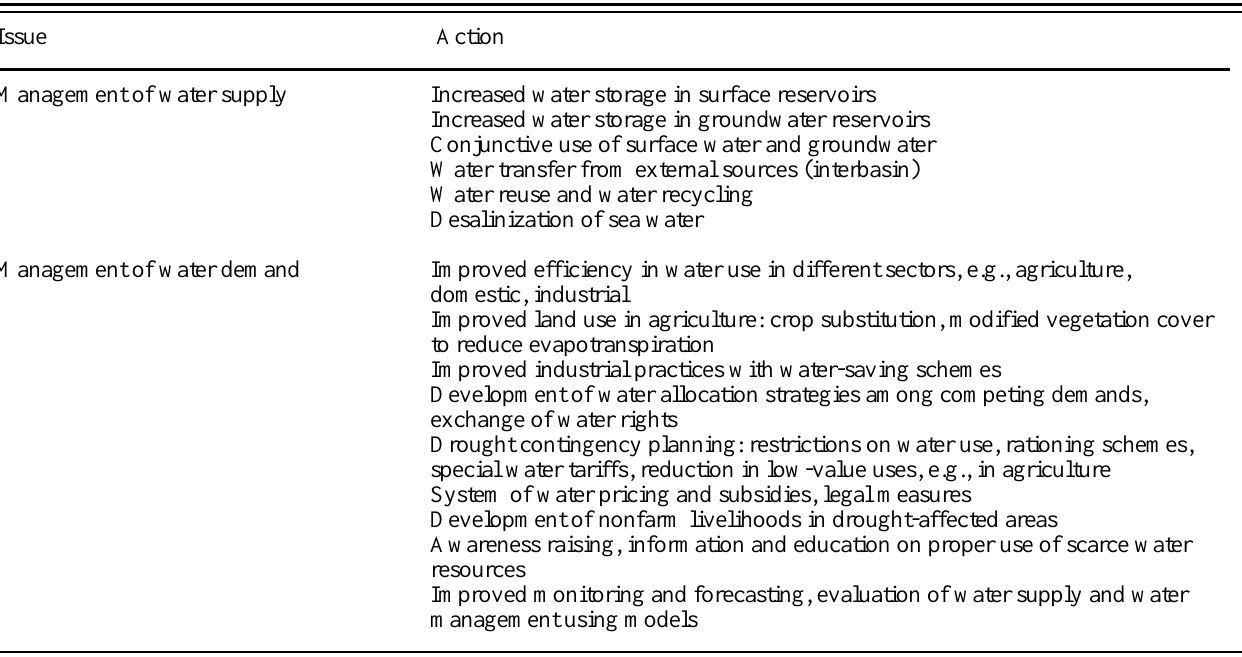
Table 3. Major drought protection